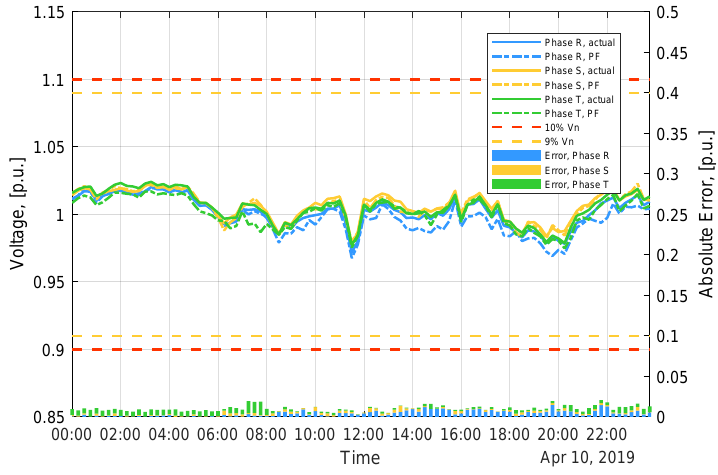
Figure 7. Model validation. Voltage profiles—Winter day.